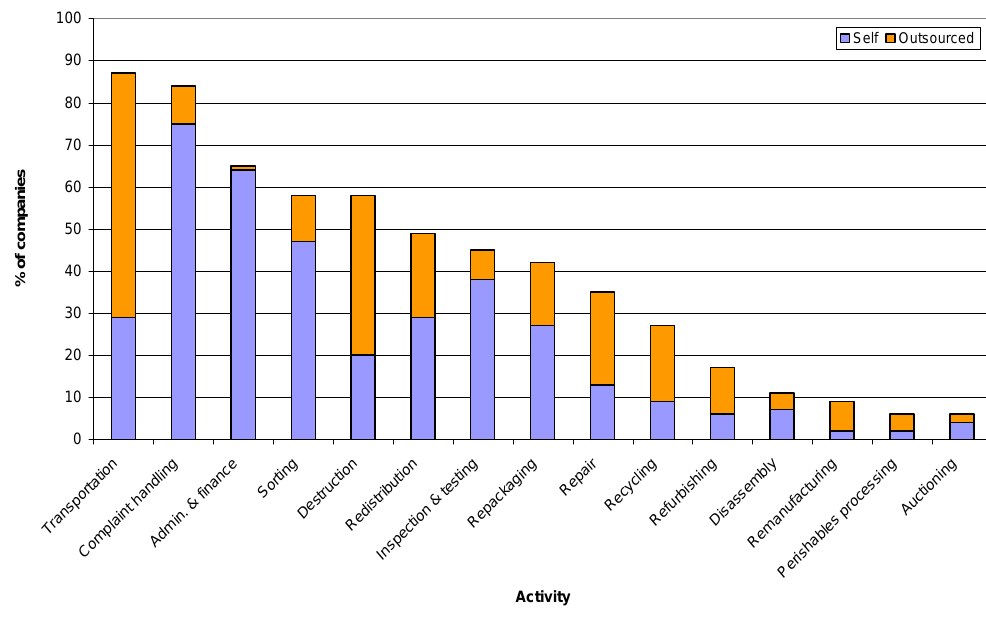
Figure 5. Level of outsourcing for reverse logistics